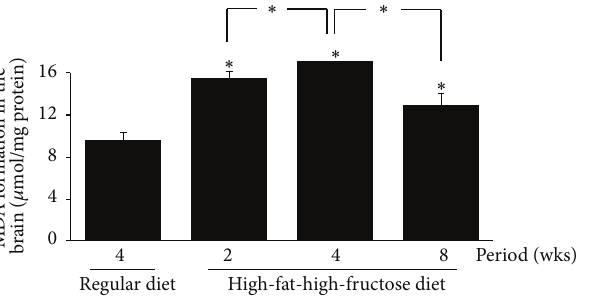
Figure 9: Effects of a high-fat, high-fructose diet on lipid peroxidation in the mouse brains. Mice were fed a commercial standard diet for 4 weeks, and a high-fat, high-fructose diet (HFFD) was administered intragastrically for 2, 4, or 8 weeks. The mice were sacrificed 24h after the last treatment, and their brains were immediately excised to determine the levels of malondialdehyde (MDA). The data are presented as the mean ± SD ( 𝑛 = 5 ). Significant differences were determined using a one-way analysis of variance (ANOVA) followed by Tukey’s post hoc test. ∗ 𝑝 < 0.05 versus the regular diet